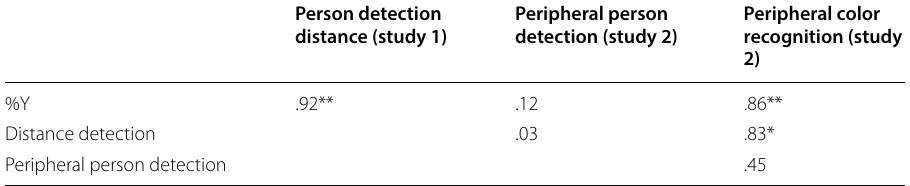
Table 2 Correlation coefficients of luminance, chromaticity, distance person detection (study 1, n 8), and peripheral person detection and color recognition scores (study 2, = n 10) =